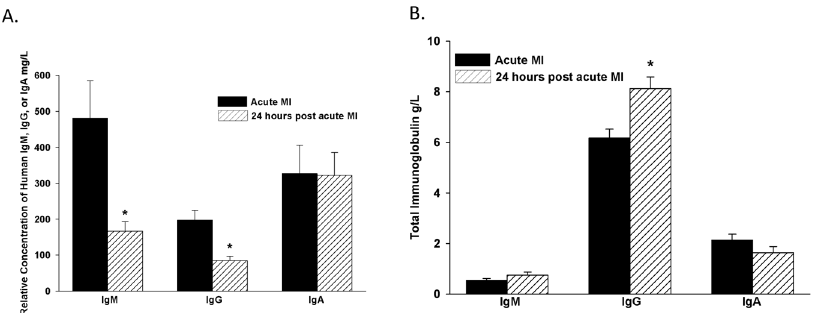
Figure 3. Serum Concentrations of IgM, IgG and IgA Antibodies 24 Hours post-AMI. A subgroup of patients (n=10) were evaluated 24 hours post-AMI for the presence of circulating IgM, IgG and IgA anti-MAA antibody levels (Figure 3A) and the total serum IgM, IgG, and IgA concentrations (Figure 3B). Results are expressed as relative mg/L or g/L of Human IgM, IgG, and IgA using a standard curve. *P , 0.01 significantly different comparing AMI and 24 hours post-AMI.